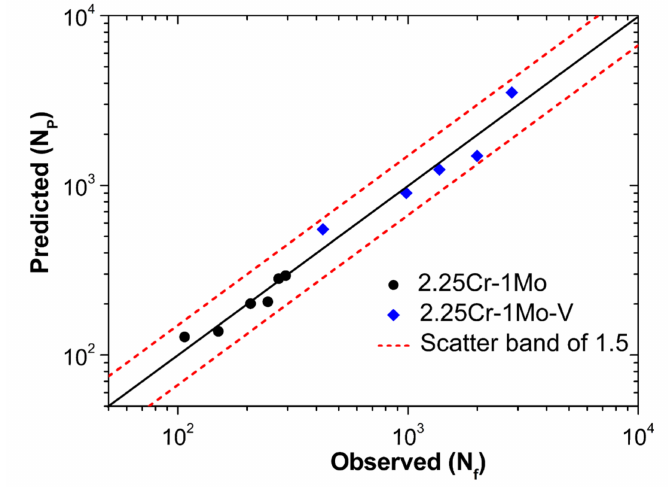
Figure 12. Comparison of predicted and observed cycles to failure in cyclic